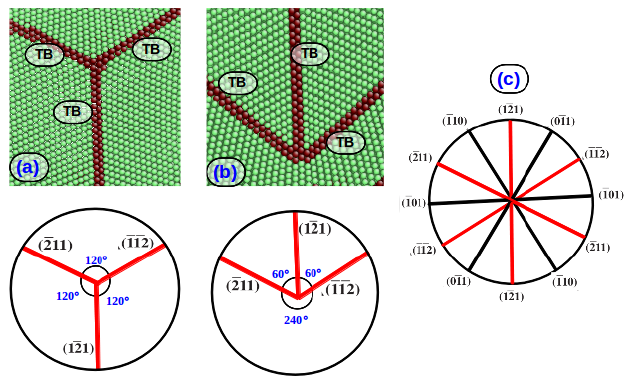
Figure 5. Two different twin–twin junctions observed in the present study; ( a ) Y-junction, where three TBs meet at an angle of 120 ◦ with respect each other, ( b ) arrow ( ↓ ) like junction, where three TBs meet at an angle of 60 and 240 ◦ , ( c ) the arrangement of {112} slip planes, when viewed along < 111 > direction. The atoms are coloured according to their common neighbour analysis